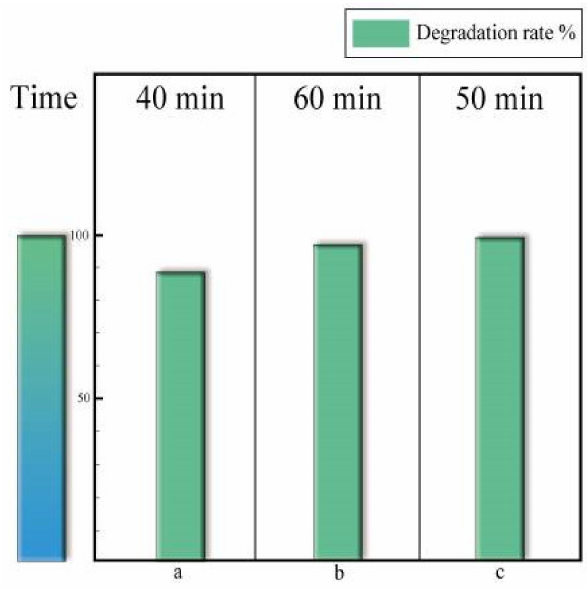
Figure 10. Degradation of 2,4-D by three iron-based catalysts: ( a ) CuFe 2 O 4 /O 3 [42], ( b ) TiO 2 @CuFe 2 O 4 /UV [69], and ( c ) Fe@C/PB